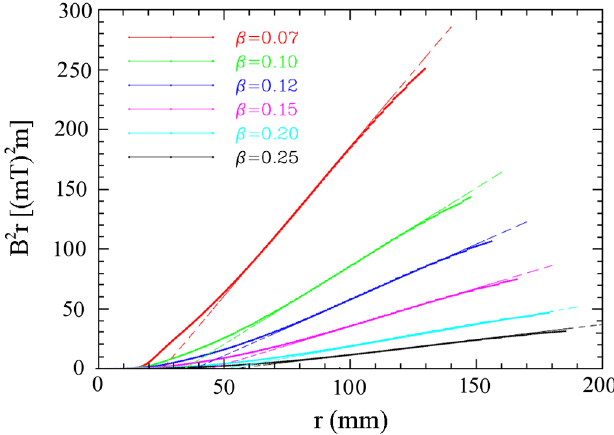
r versus r for different (cid:2) z